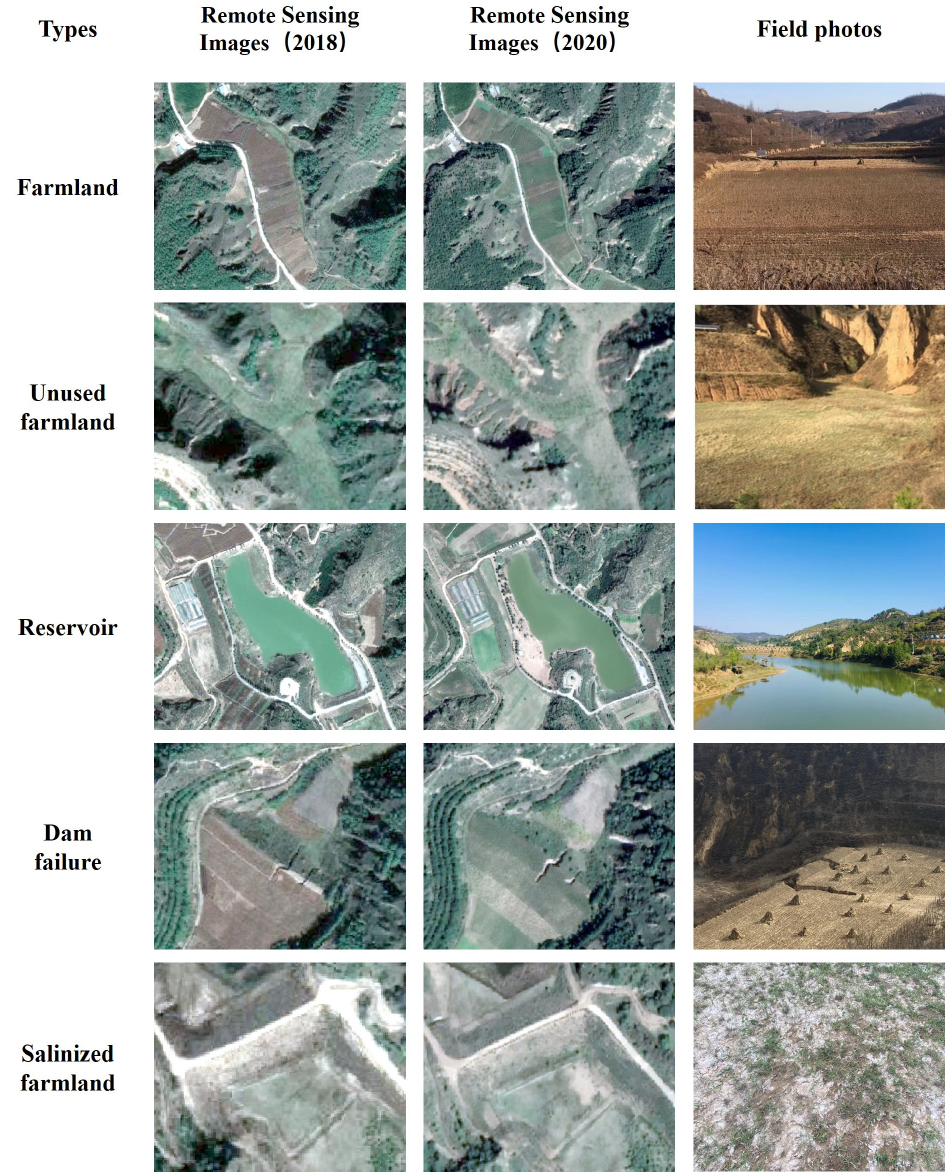
Figure 3. Examples of land use and disaster types identified by combining remote sensing images and field surveys.